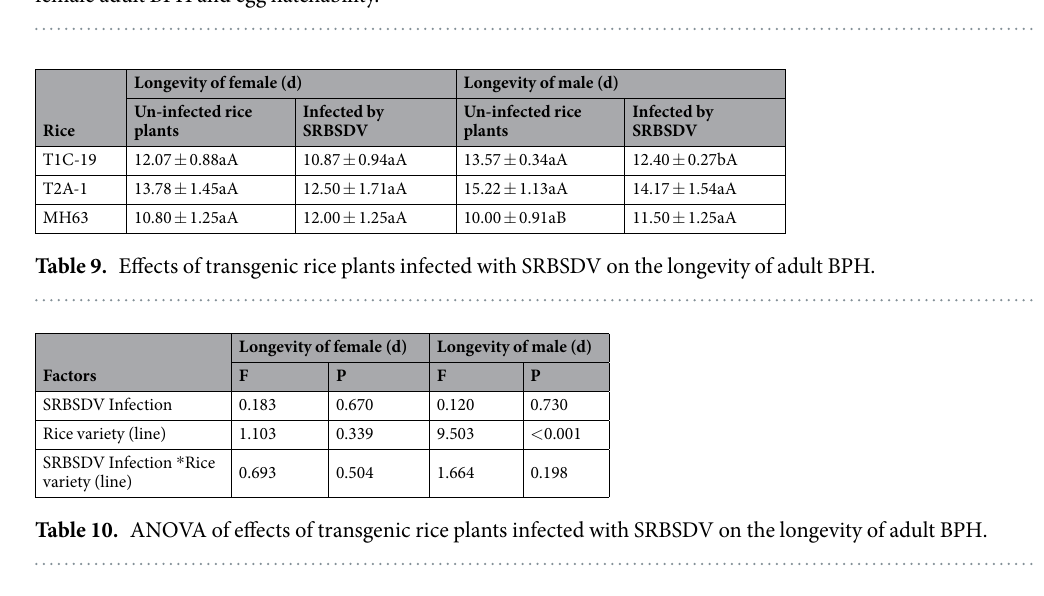
Table 10. ANOVA of effects of transgenic rice plants infected with SRBSDV on the longevity of adult